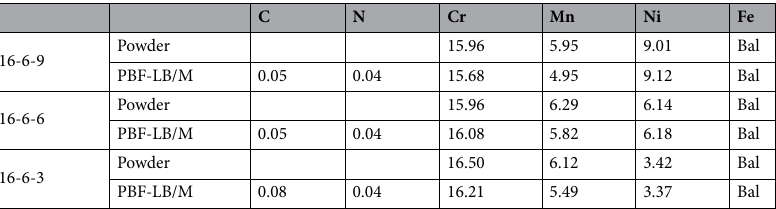
Table 1. Chemical composition of the initial powders and the PBF-LB/M manufactured parts given in wt.%. For the PBF-LB/M bulk materials also carbon and nitrogen were analyzed due to their potential influence on the finally prevailing SFE (being of highest importance for the properties of the conditions studied). For the powder materials the carbon and nitrogen contents were not analyzed.